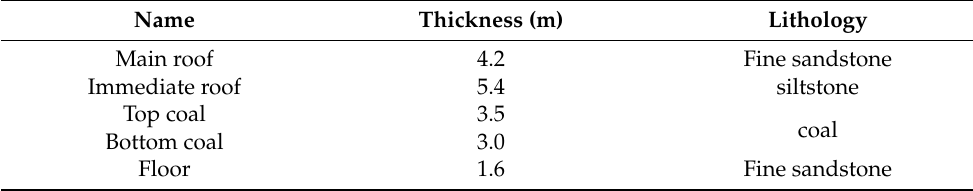
Table 1. Coal seam histogram